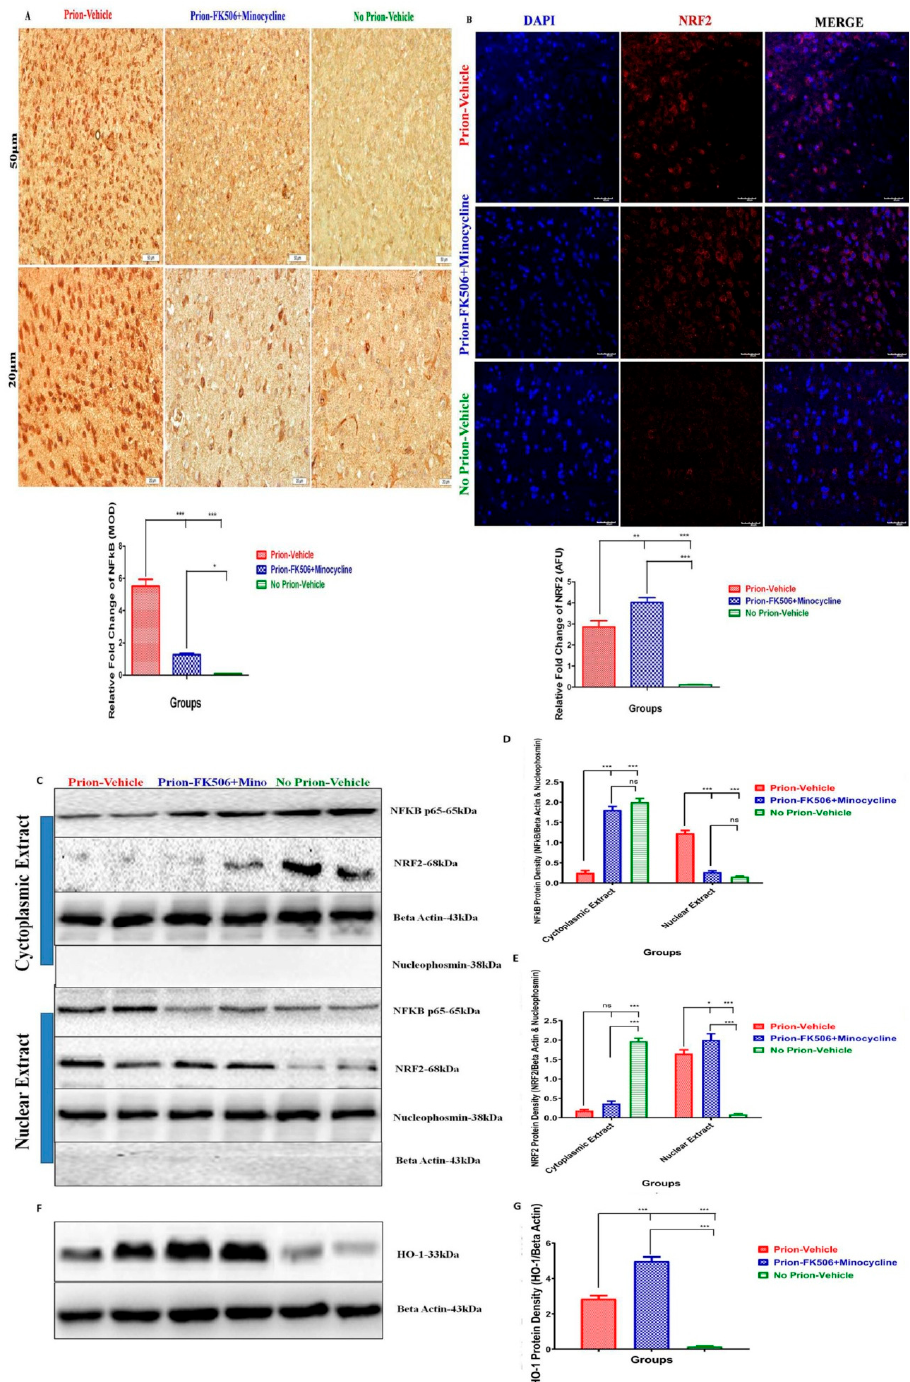
Figure 8. FK506+minocycline treatment effectively leads to reduced NF-kB p65 and increased NRF2 nuclear translocation. ( A ) Representative slides stained with NF-kB p65 adopting immunohistochemistry technique. Top three slides are low power (50 µ m) while bottom three slides are high power (20 µ m). Graphical presentation at the bottom showing expression of NF-kB p65 in prion infected and non infected groups. Slides from 5 animals each per group were selected for statistical analysis. The data was analyzed using one way ANOVA test followed by post hoc test tukey’s multiple comparison. ( P ≤ 0.05 = * and P < 0.0001 = ***). (MOD= mean optical density). ( B ) Representative pictures of confocal microscopy for